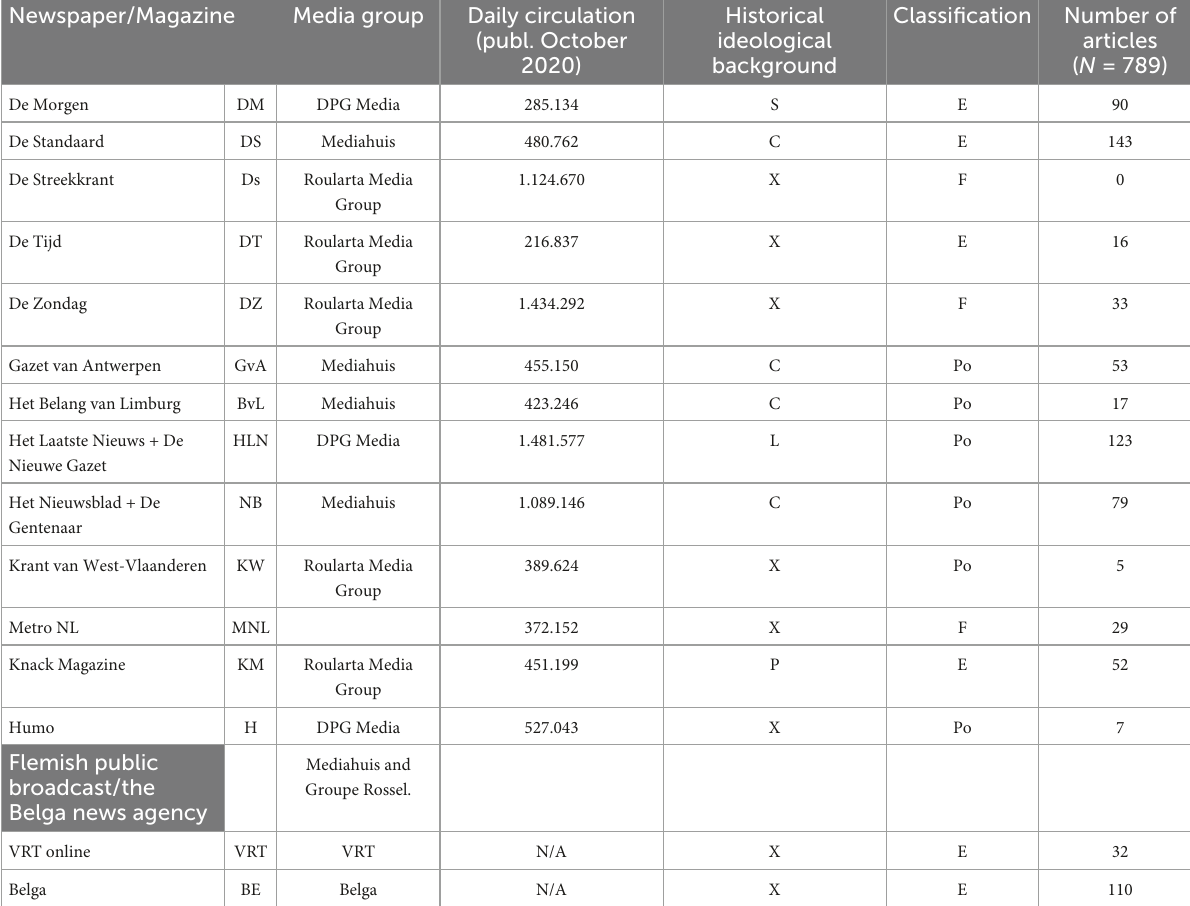
TABLE 1 Newspapers and magazines’ circulation, historical ideological background, and classification.